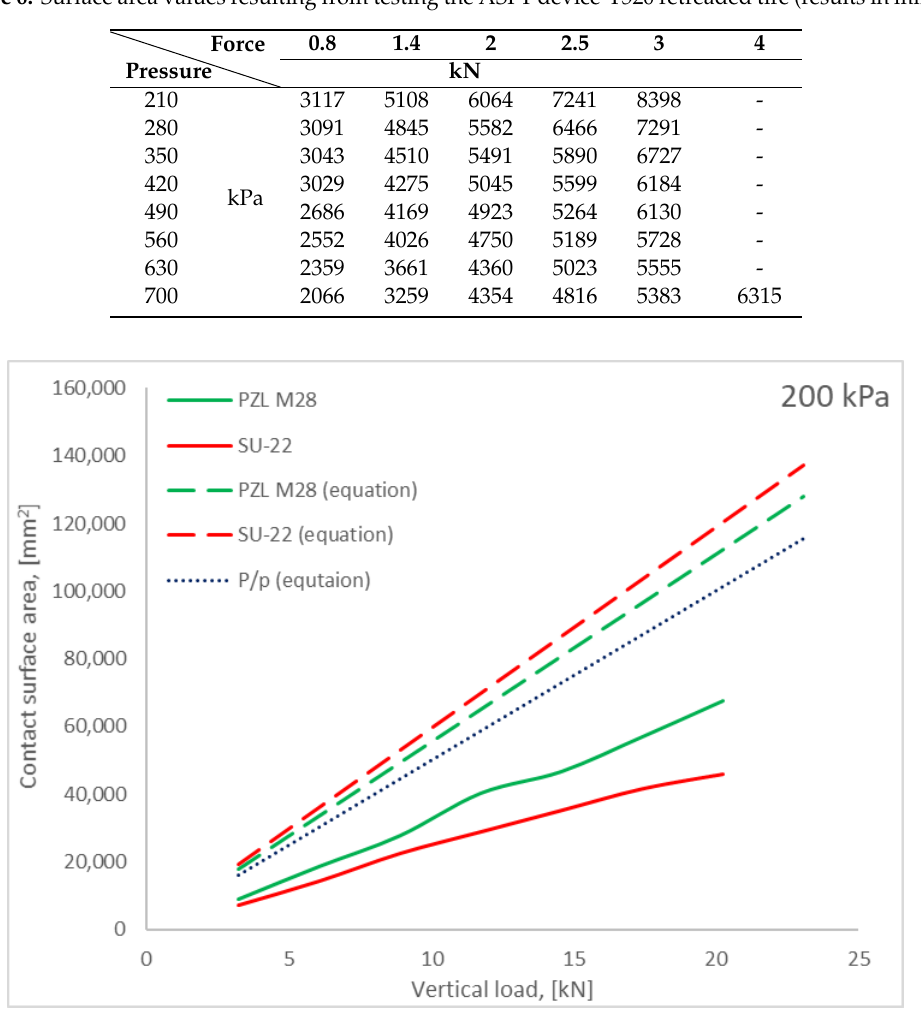
Figure 14. Contact surface area of the aircraft tire with the surface, in relation to the load for the wheel pressure of 200 kPa.